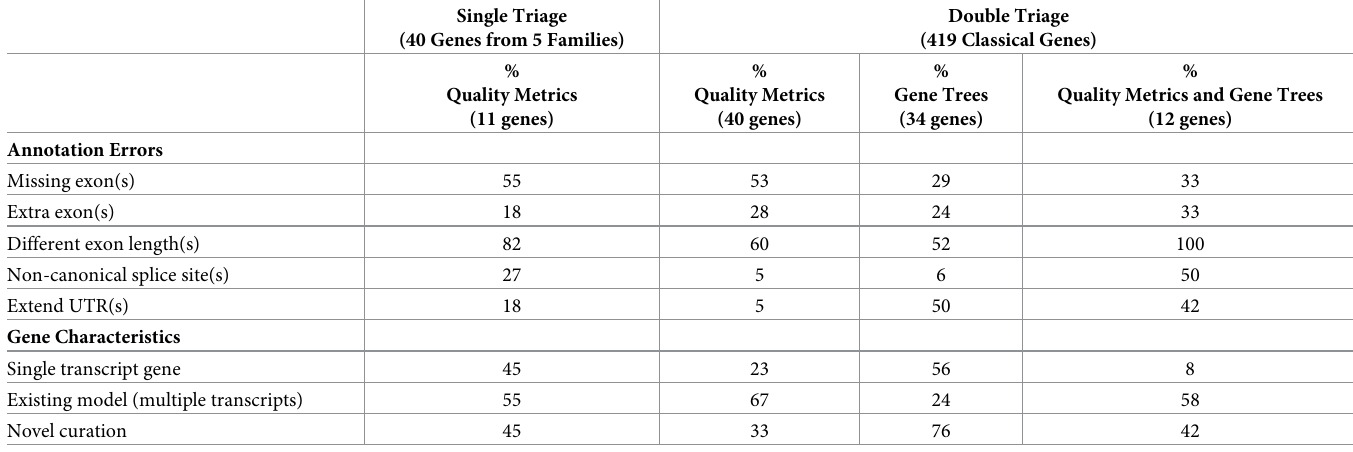
Table 1. Annotation errors and characteristics of maize genes identified by quality metrics and gene trees. Errors found in 11 genes flagged by quality metrics in five maize gene families (25 transcripts). Errors found in 40 genes flagged by quality metrics, 34 genes flagged by gene trees and 12 genes flagged by both methods in 419 maize classical genes (2,127 transcripts).